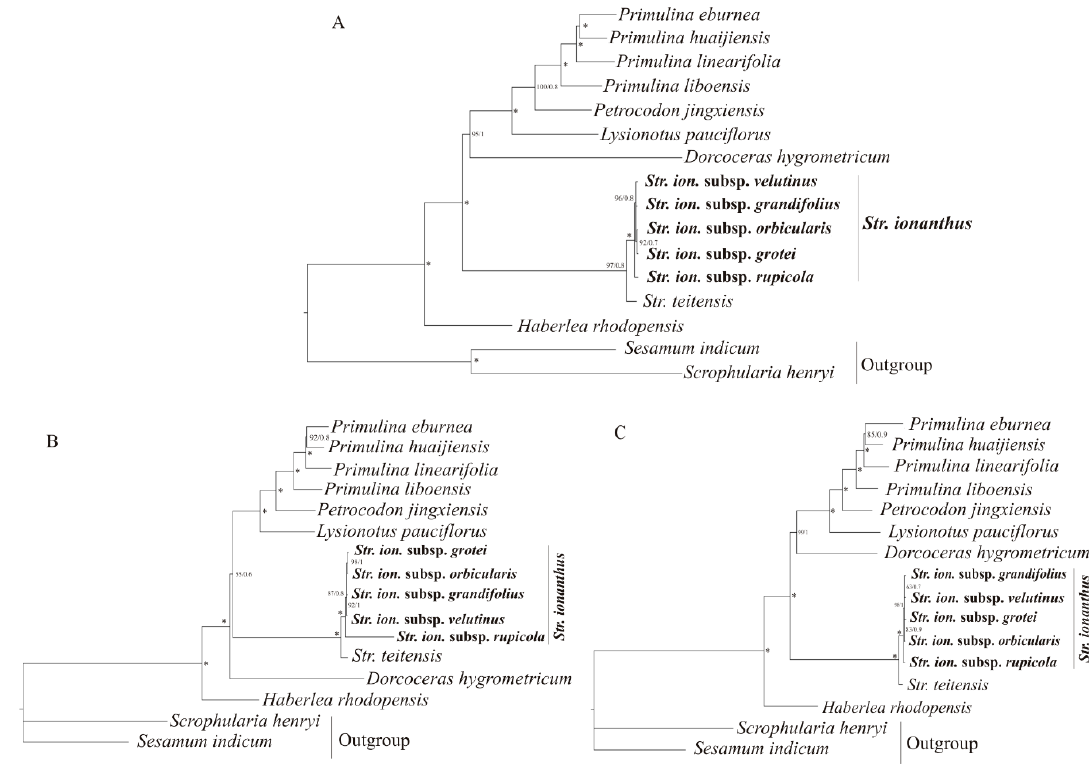
Figure 6. The phylogenetic relationship within five Str. ionanthus subspecies and the relationship with other Gesneriaceae based on ( A ) complete genome sequence and ( B ) coding genes and ( C ) intergenic regions. The bootstrap support values are given for both Maximum Likelihood (ML) and Bayesian Inference (BI) trees (ML/BI) and * denote maximum support values for both ML/BI.